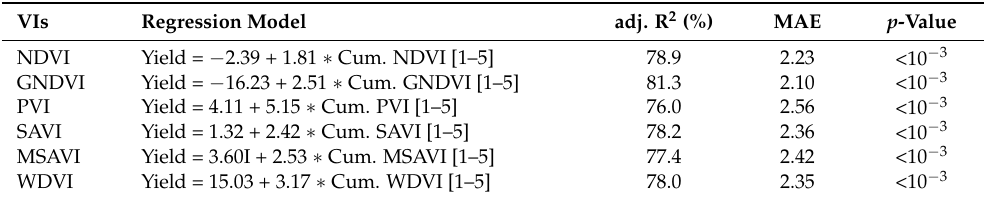
Table 18. The regression models that best describe yield (expressed in t/ha) through VI data for the maximum cumulative range [1–5], along with their adjusted R-Squared and MAE values (All VIs presented significant correlations at the p < 0.05